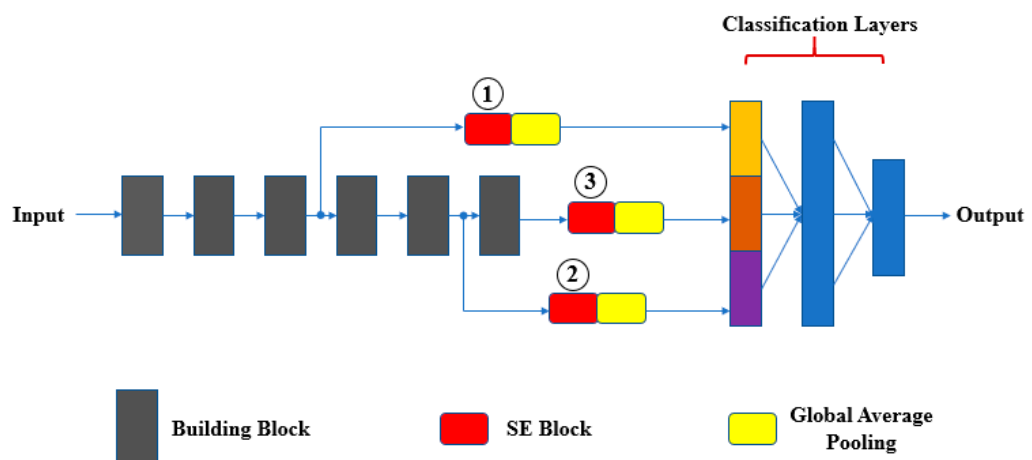
Figure 7. Application of SE (Squeeze-and-Excitation) blocks in testing the importance of middle layer features for classification. This network architecture is called Multi-Scale-Net (MSN) and is compared with other benchmark networks in Section 5.